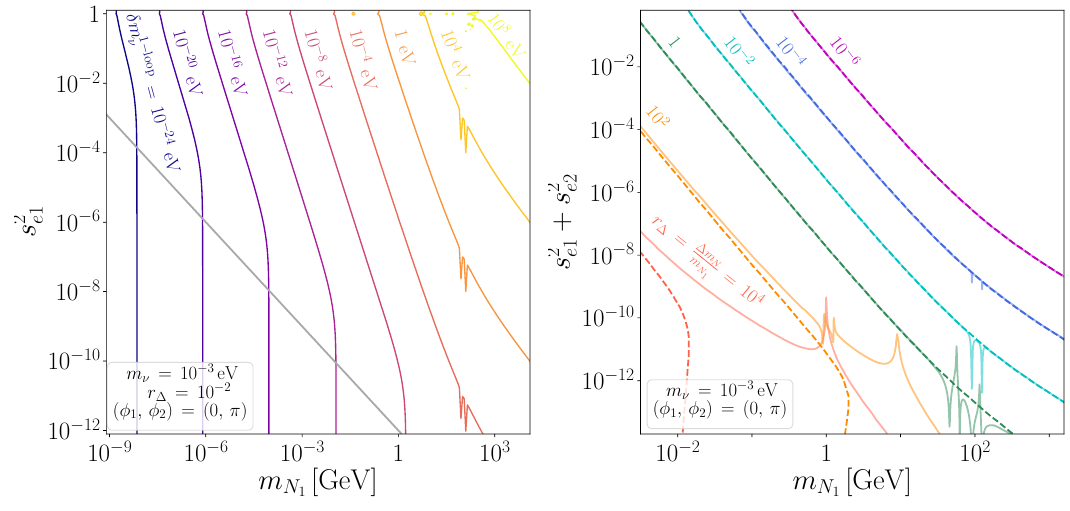
Figure 4 . Left: Absolute magnitude of the one-loop neutrino mass contribution function of the lighter sterile mass m N parameters. The canonical seesaw case with s 2 Maximally allowed value of s 2 di(cid:11)erent values of the heavy neutrino splitting ratio r (cid:1) = (cid:1) m N exact formula eq. (2.13), while the dashed lines use this same formula but in the limit (cid:22) R;S given by ref.